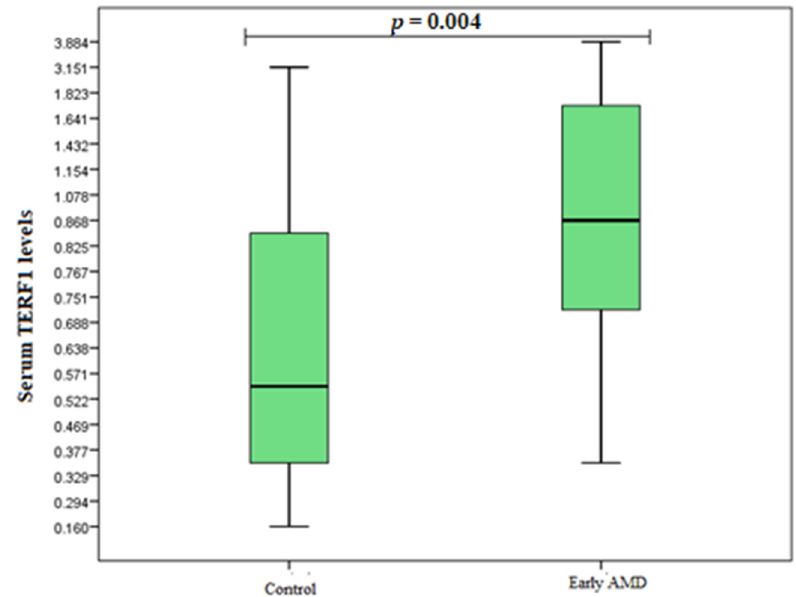
Figure 4. Serum levels of TERF1 in patients with early AMD and control group. AMD: age-related macular degeneration; Serum protein values are presented as median and IQR. Mann–Whitney U test was used to assess serum TERF1 levels differences between patients with early AMD and control groups; p = 0.004.